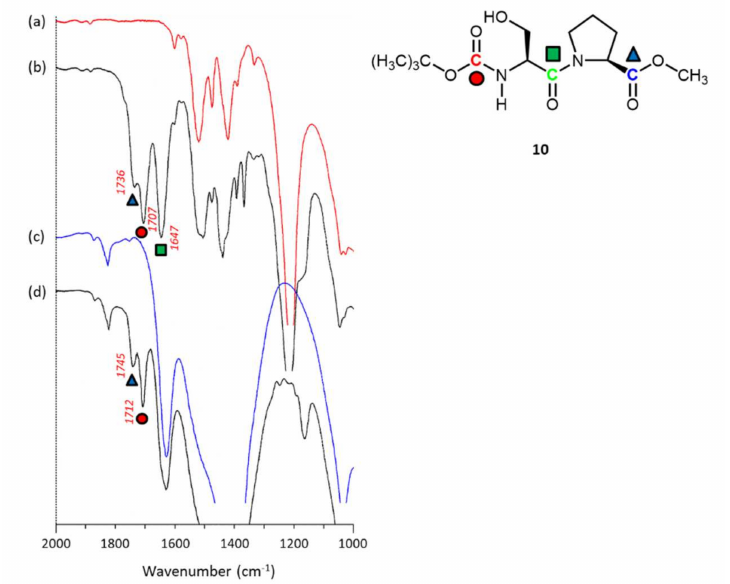
Figure 20. IR spectra of N -Boc-L-serine-L-proline-OMe 10 : ( a ) CHCl 3 (red line); ( b ) 20 mmol/L of 10 in CHCl 3 ; ( c ) acetonitrile (blue line); ( d ) 20 mmol/L of 10 in acetonitrile.